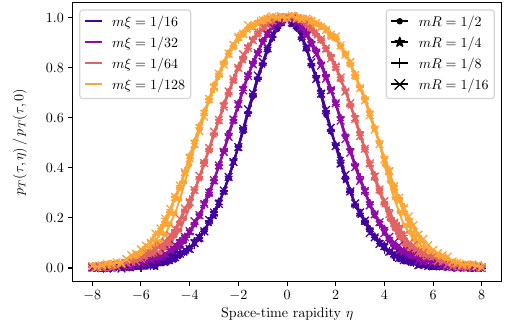
Figure 4. Normalized rapidity profile of the transverse pressure p T as a function of space-time rapidity η for various values of R and ξ ( ξ (cid:2) R ) at late times τ (cid:12) R . We observe that the width of the profile only weakly depends on the dimensionless longitudinal width mR (same color, various markers), but strongly depends on the longitudinal correlation length m ξ (various